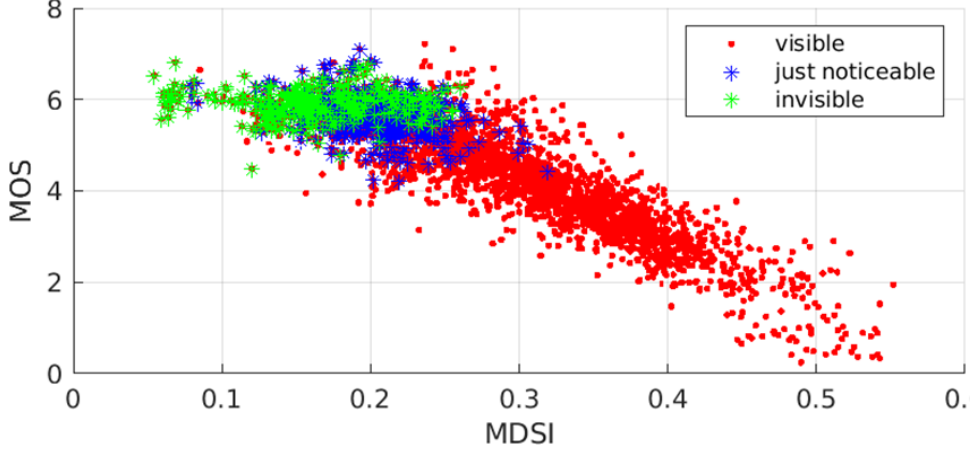
Figure 1. The scatter plot of MDSI vs. MOS for the TID2013